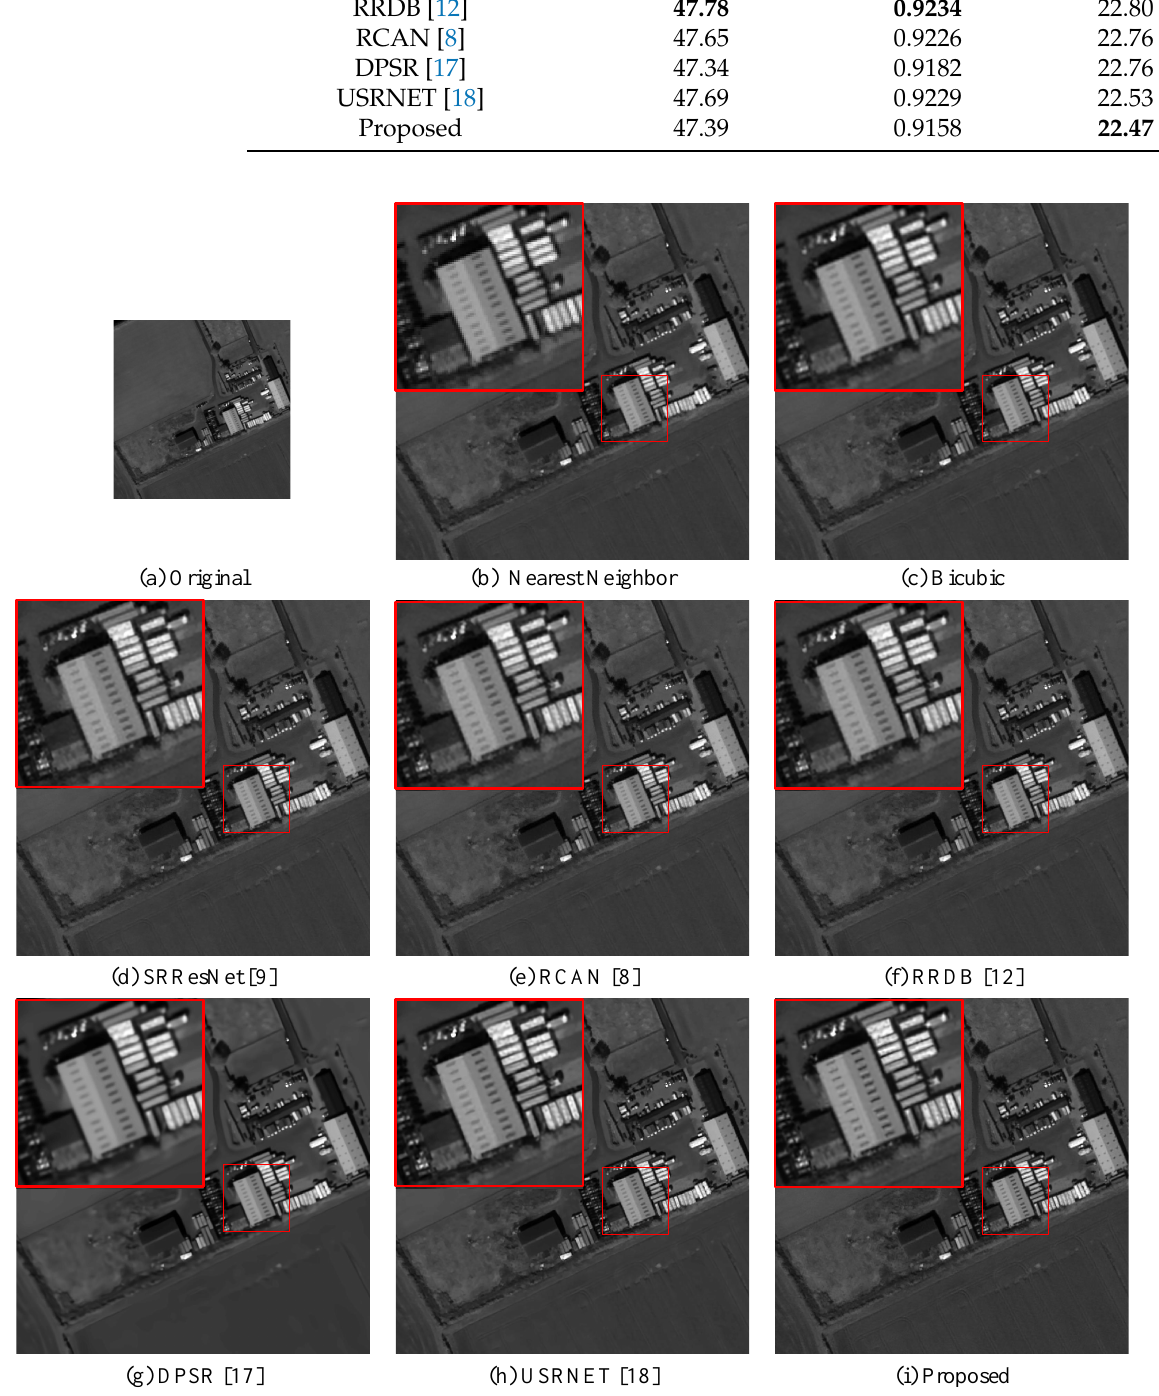
Figure 6. Visual qualitative comparisons of the proposed method with other SR methods on a panchromatic image, Two Stroke To Turbo LTD,